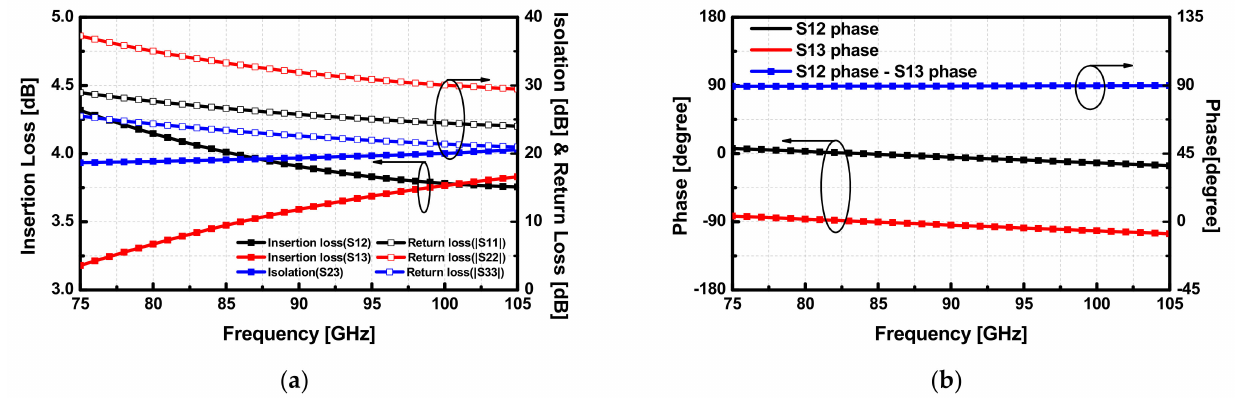
Figure 9. Simulation result of the ( a ) insertion loss, isolation and ( b ) phase response for the designed Lange coupler.